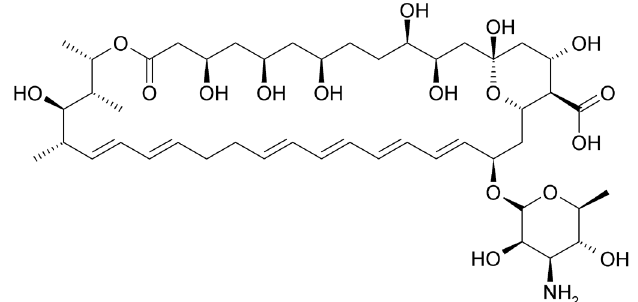
FIGURE 1 – Chemical structure of